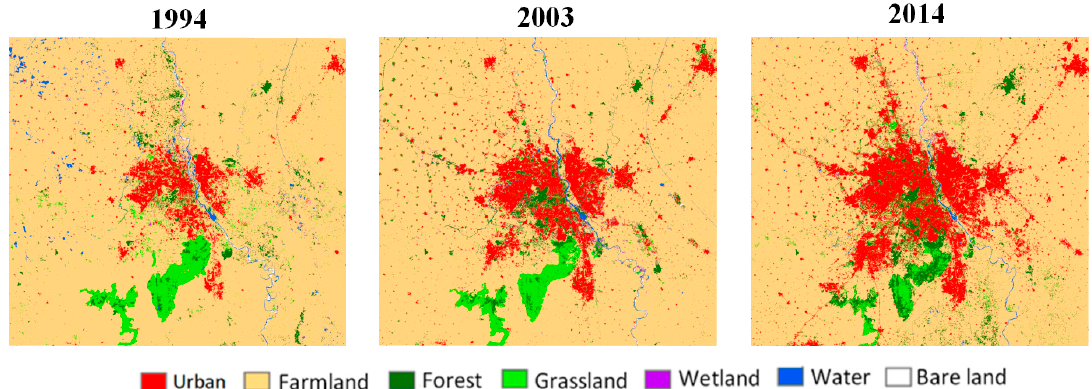
Figure 5. The LULC maps from 1994 to 2014 used to derive the MC transition probability